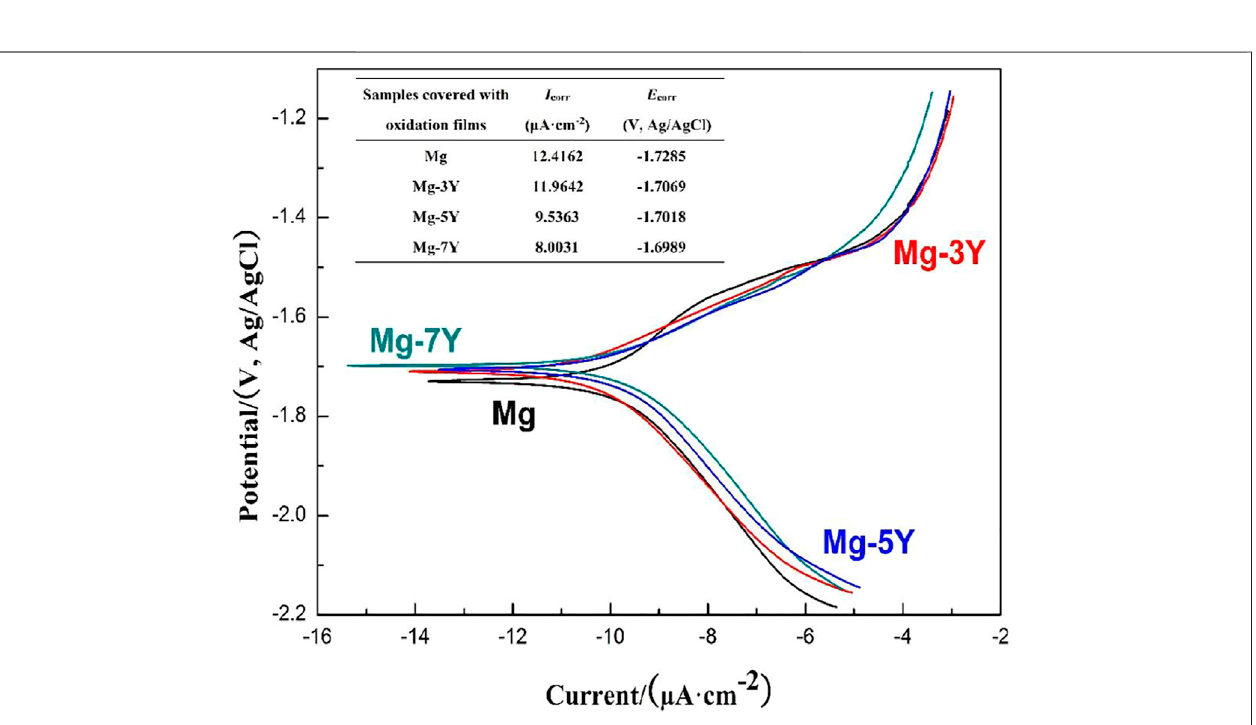
FIGURE 6 | The electrochemical Tafel slopes of samples covered with oxidation fi lms in the surface measured in 3.5% NaCl solution.